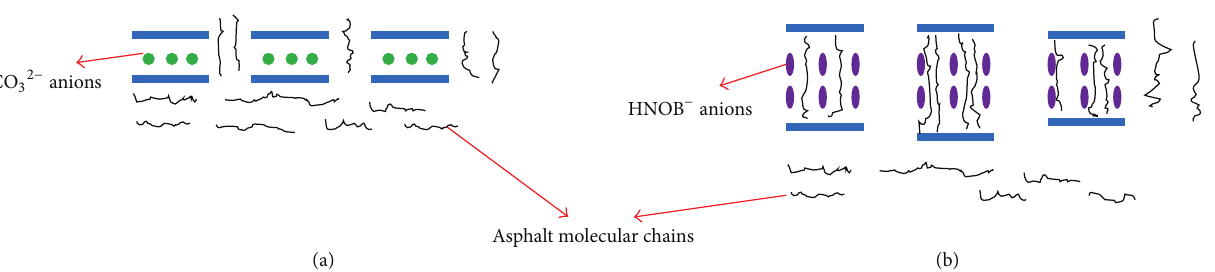
Figure 5: Schematic models of (a) separated phase and (b) expanded phase structures.